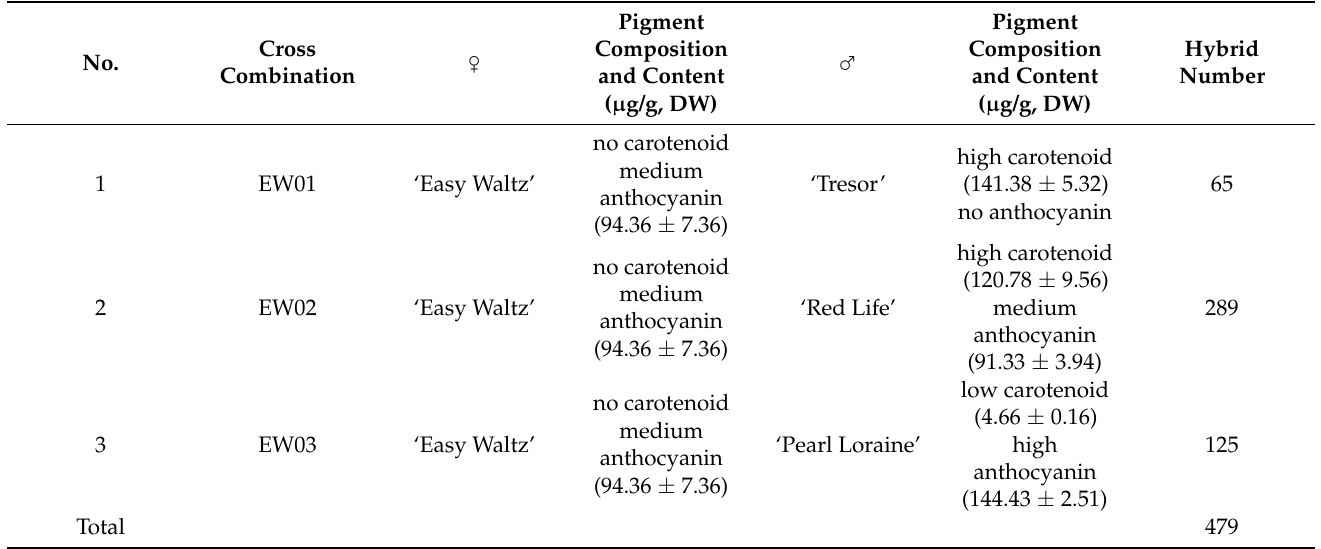
Figure 1. The parents of hybridizations. ♀ : maternal parent; ♂ : paternal parent. Table 1. Pigment composition and content of parents and number of F1 hybrids in three cross combinations.